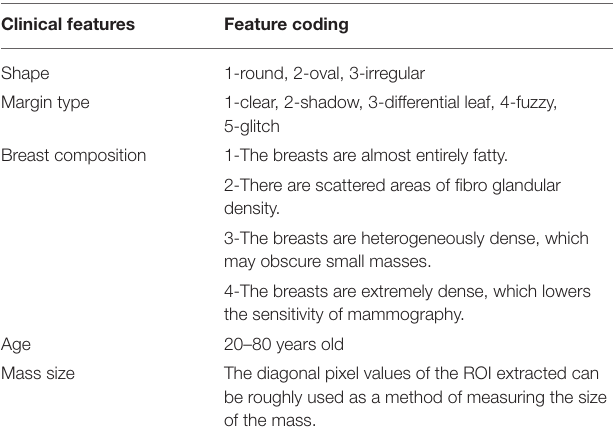
TABLE 2 | Clinical features description of patients.